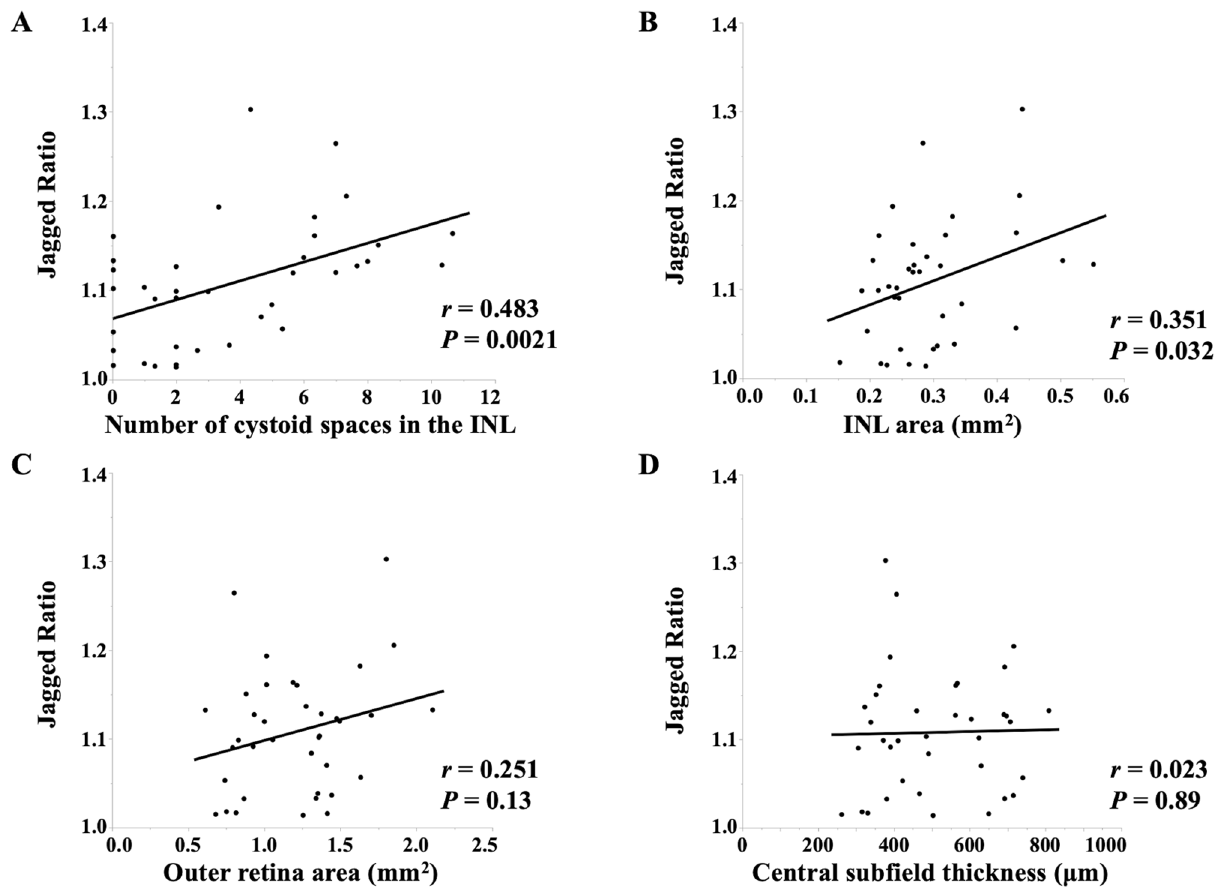
Figure 2. The scatterplots show the correlations between jagged ratio (JR) and optical coherence tomography parameters at the initial visit. The number of cystoid spaces in the inner nuclear layer (INL) ( r = 0.483, P = 0.0021) and INL area ( r = 0.351, P = 0.032) were significantly correlated with JR. Figure is created using JMP version 15.2.1 (SAS Institute, Inc., Cary, NC, USA, available at https:// www. jmp. com/ ja_ jp/ home. html).